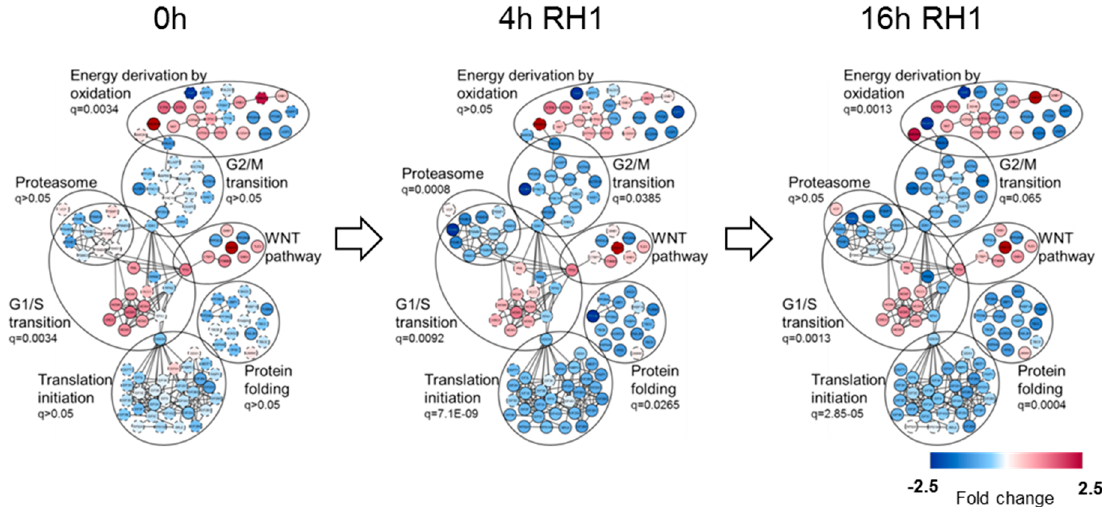
Figure 2. Functional analysis of global proteome dynamic changes between MDA-P and MDA-R cells. MDA-P and MDA-R cells, untreated or treated with 20 nM RH1 for 2 h followed by 2 or 14 h recovery period (4 and 16 h from the beginning of treatment respectively), were subjected to in-depth quantitative proteomic analysis. Protein di ff erential expression, interaction and functional annotation network was built by means of Cytoscape software with GeneMANIA application. The main functional clusters with enrichment q-value are represented. The color of the nodes demonstrates protein level change in RH1-resistant MDA-R cells.